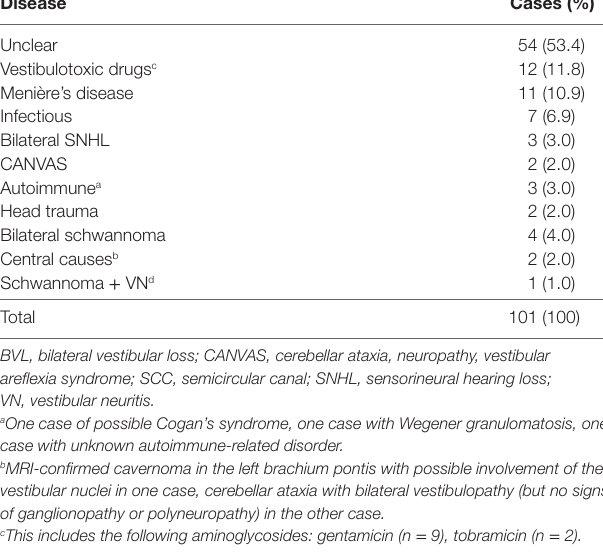
TaBle 2 | Epidemiological findings of the 101 patients with BVL and both SCC and otolith testing available. Disease